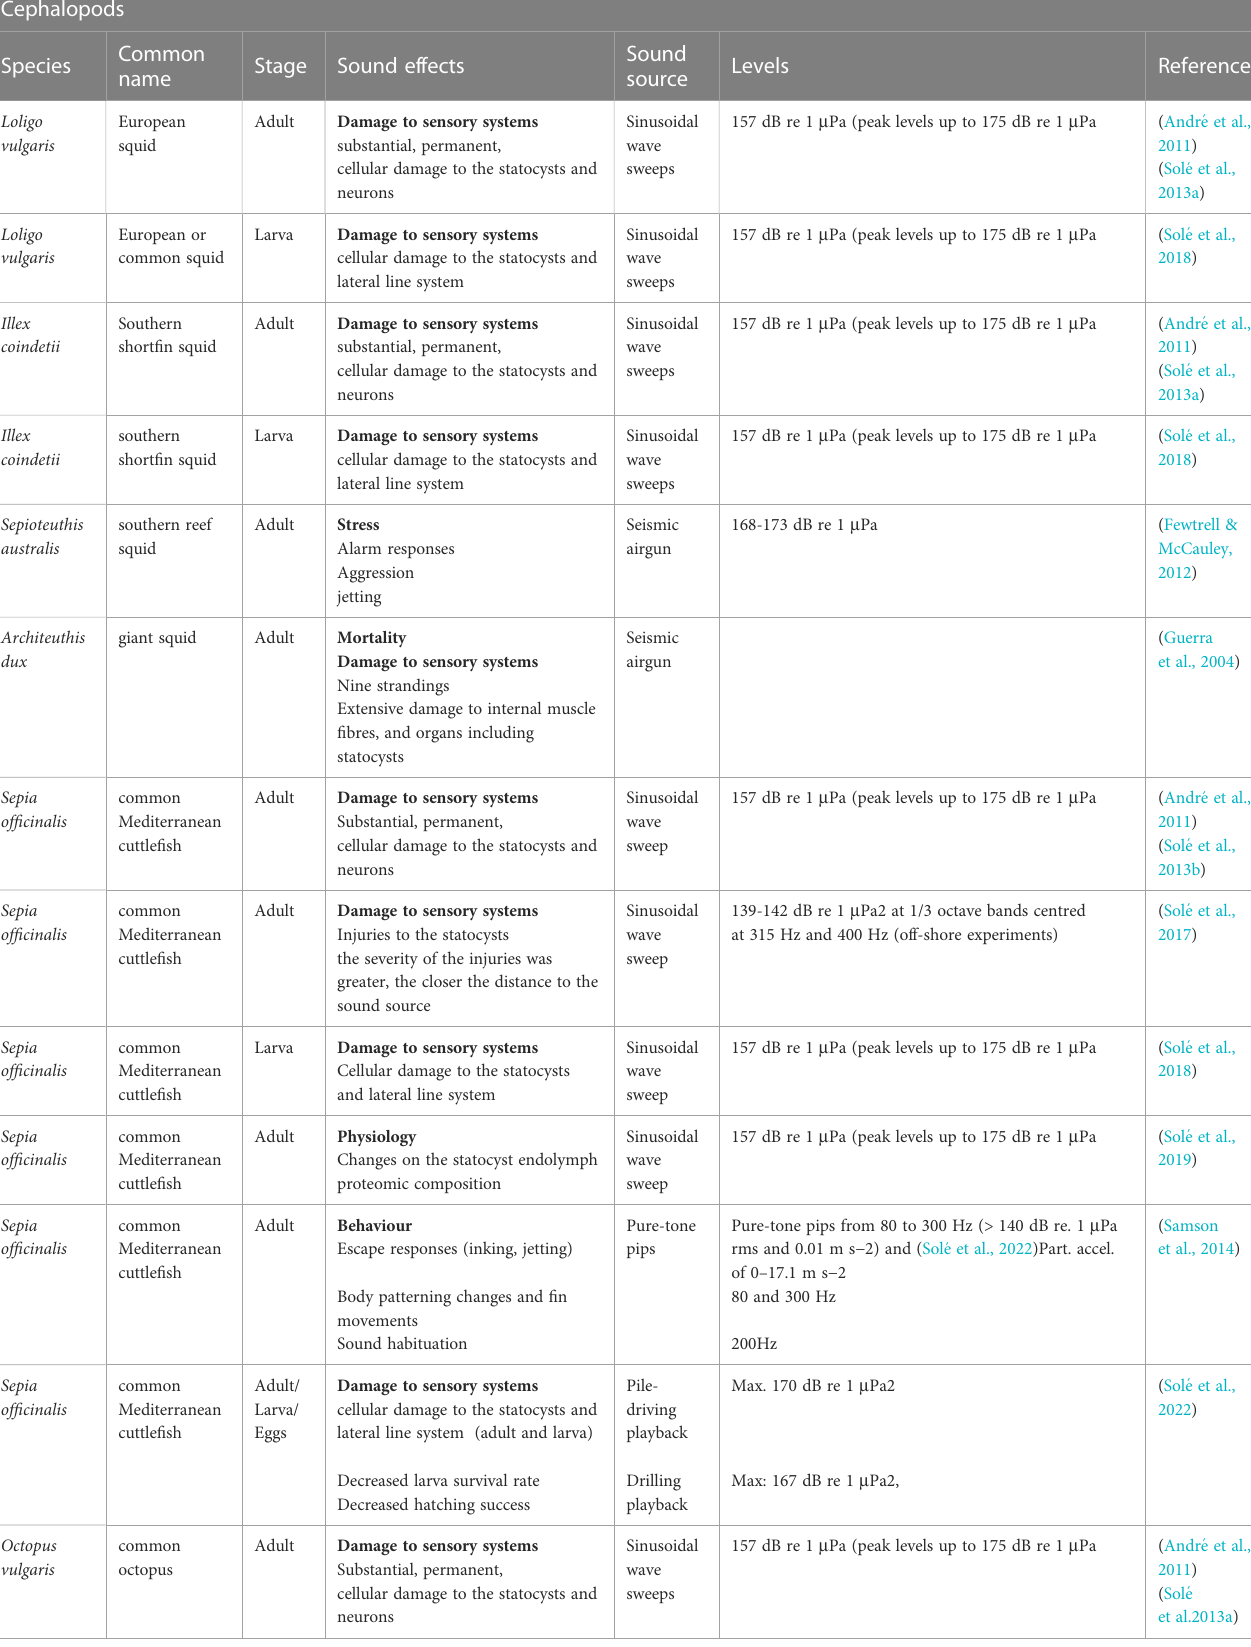
TABLE 5 Relevant studies on noise impact on